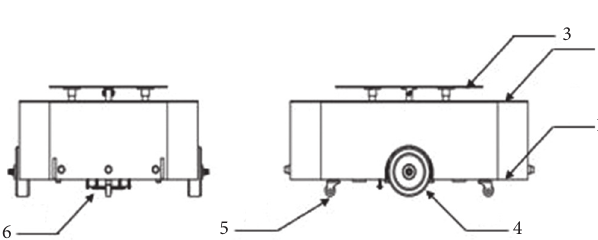
Figure 1: The illustration of our platform, which comprises (1) base, (2) upper cover, (3) lifting part, (4) actively driving wheel, (5) caster wheel, and (6) sensors (line tracking, magnetic tracking and so on).